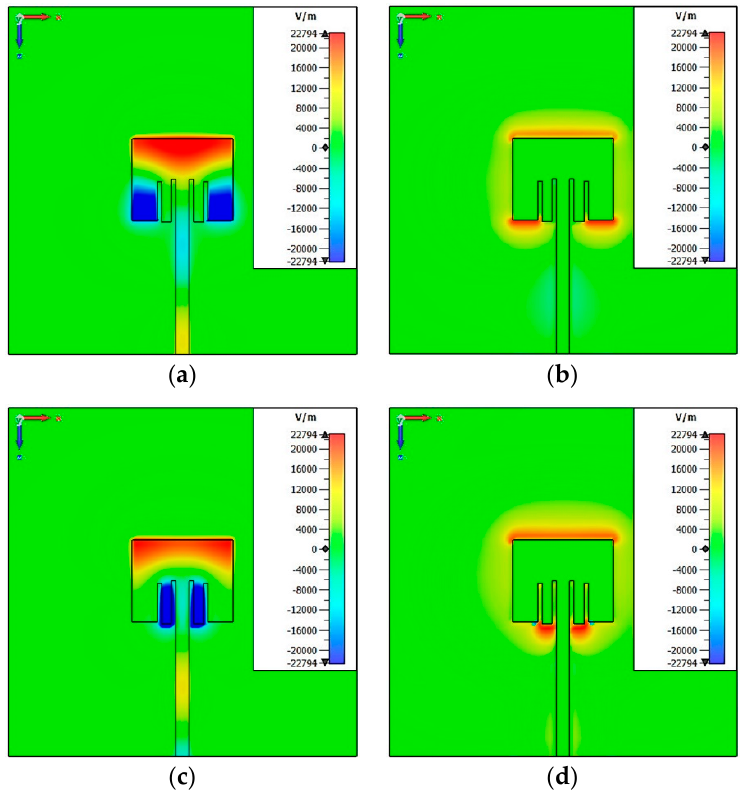
Figure 3. MPA2 E-field plots: ( a ) E y @ 9.88 GHz, ( b ) E z @ 9.88 GHz, ( c ) E y @ 10.120 GHz, ( d ) E z @ 10.120 GHz.